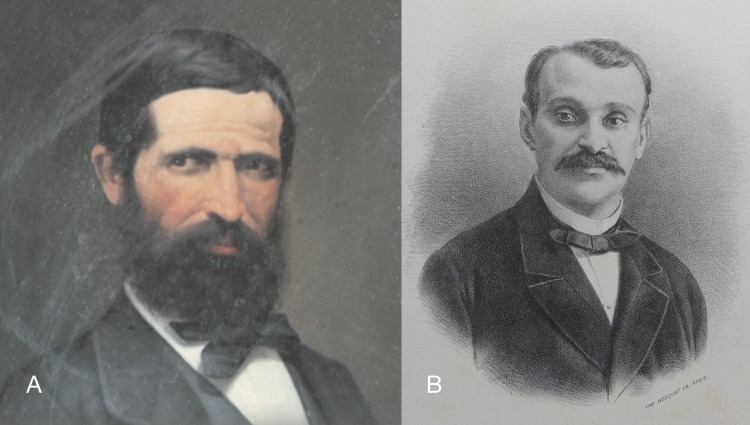
Portraits of persons mentioned in this study.(A) Juan Isern, unknown date (Blanco, Rodríguez & Rodríguez, 2006); (B) Joaquin Hidalgo, 1882 (Crosse archive).